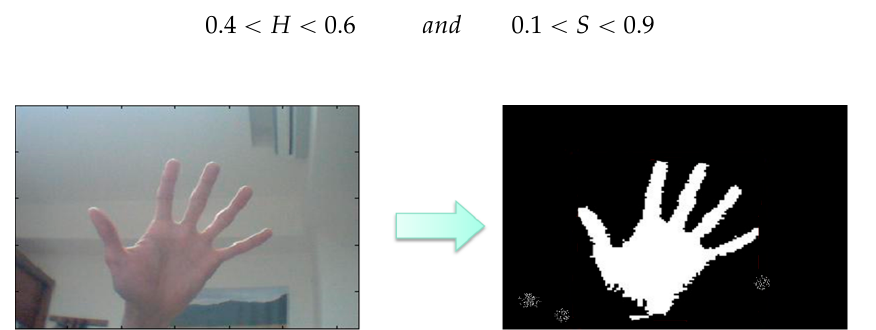
Figure 6. The result of skin color segmentation.